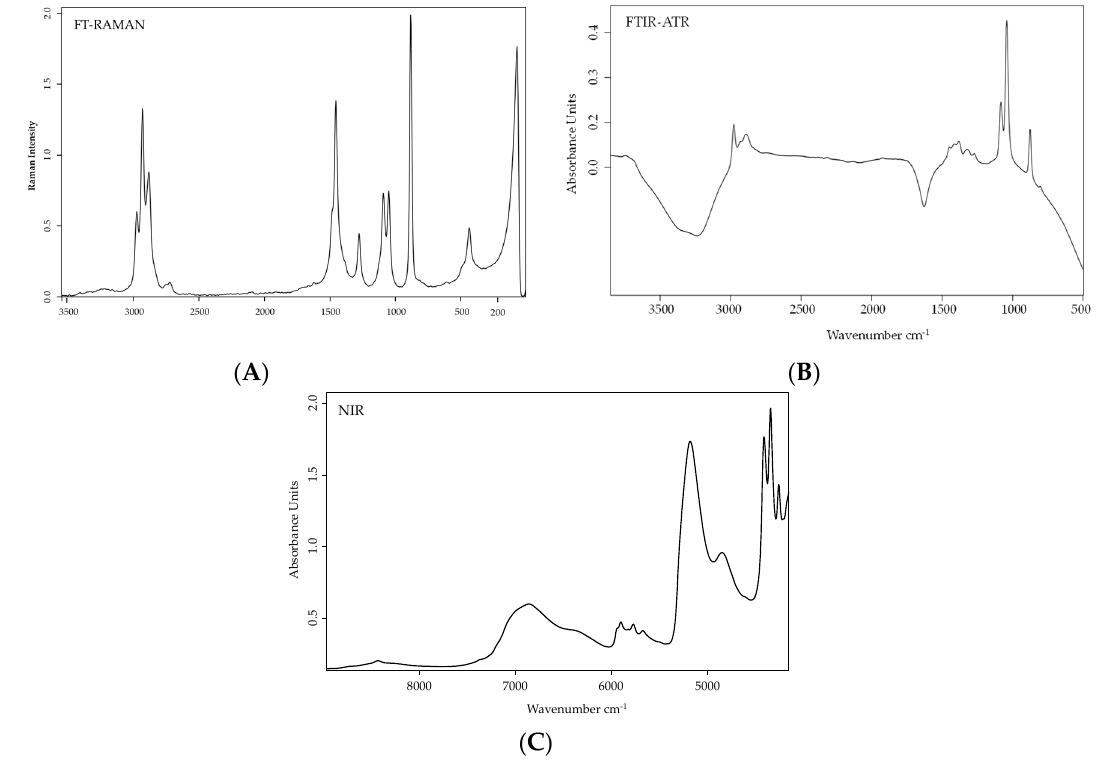
Figure 2. Spectra of wine spirit with 3 months of aging in wood collected in ( A ) FTIR-ATR [125]; ( B ) FT-RAMAN [21] and ( C ) NIR [126].